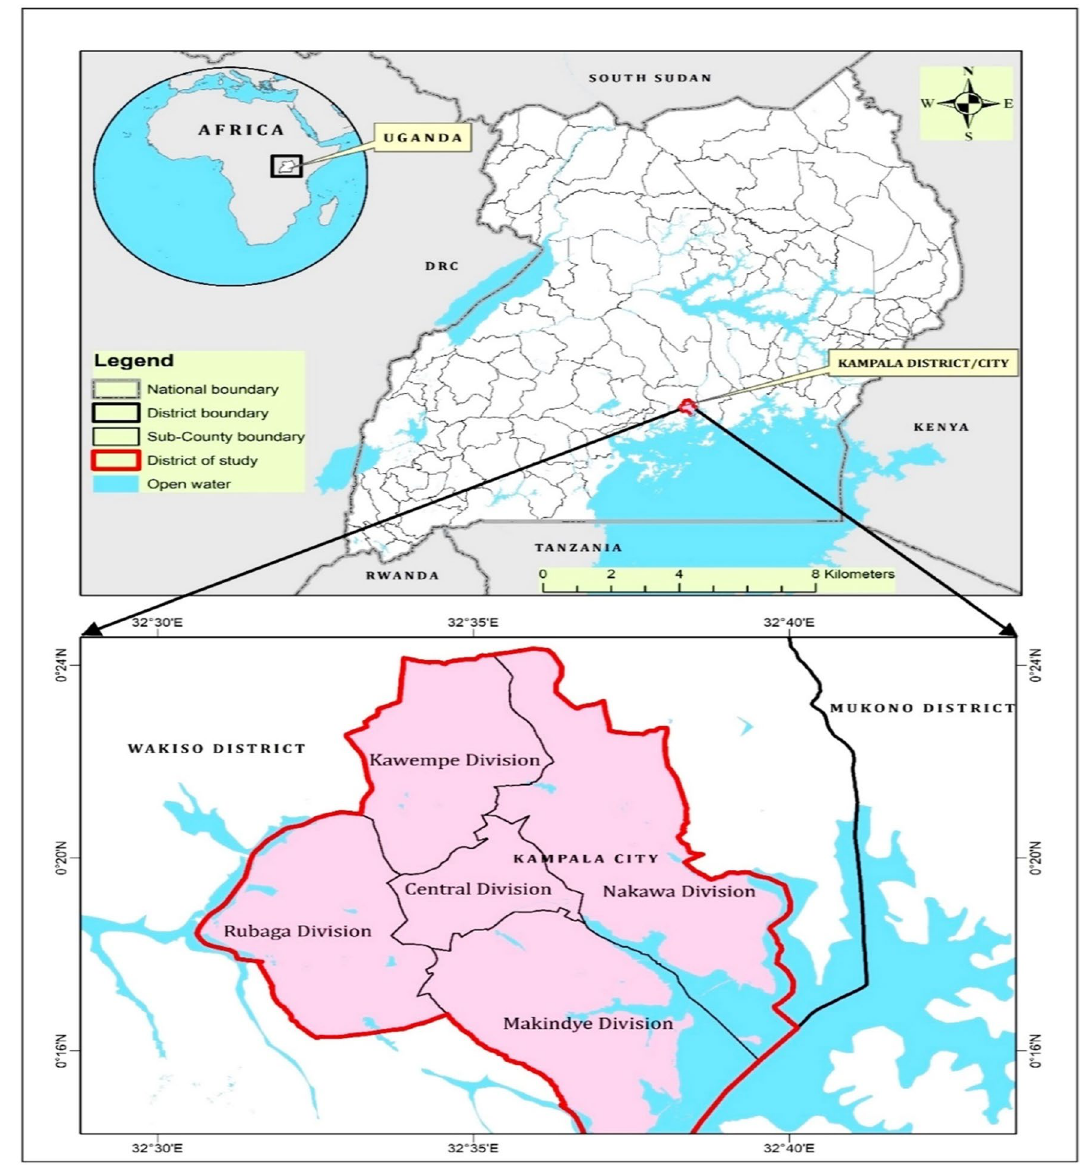
Figure 7. Study locale: Kampala city showing the five administrative